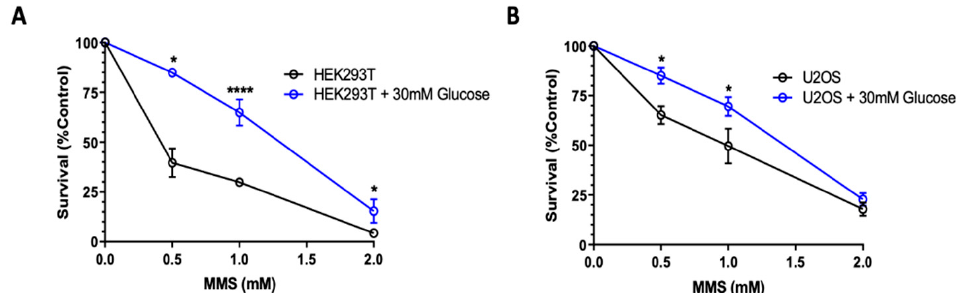
Figure 3. Increased MMS survival following acute high glucose exposure: survival curve of HEK293T ( A ) and U2OS ( B ) cells in basal glucose medium and with 30 mM glucose pre-treatment for 4 h, then co-exposure with MMS for 1 h, and continued exposure after MMS removal. The mean survival ± standard error of the mean (SEM) (%) normalized to 0 mM control is shown. * p < 0.05, **** p < 0.0001.